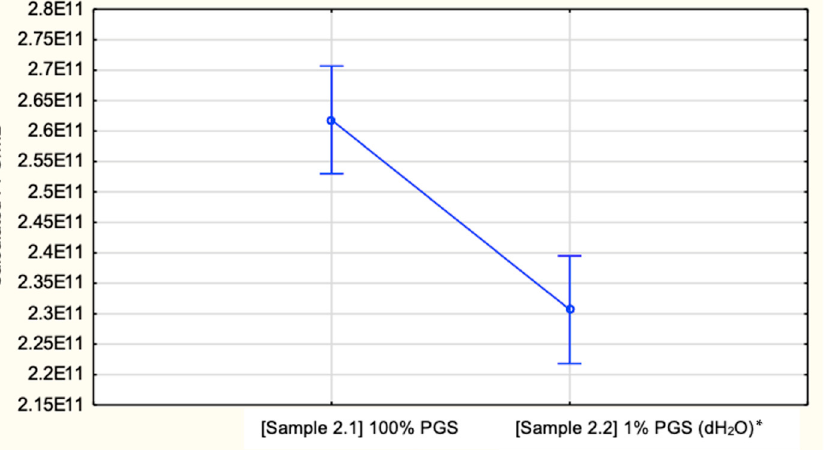
Figure 4. Calculated PFU/mL before and after dilution to 1% (dH 2 O) (samples 2.1 and 2.2, respec- tively). * To draw parallels between sample counts of 2.1 and 2.2, sample 2.1 (1% dilution = 2.31 × 10 9 ) was calculated to reflect a theoretical stock concentration (undiluted).